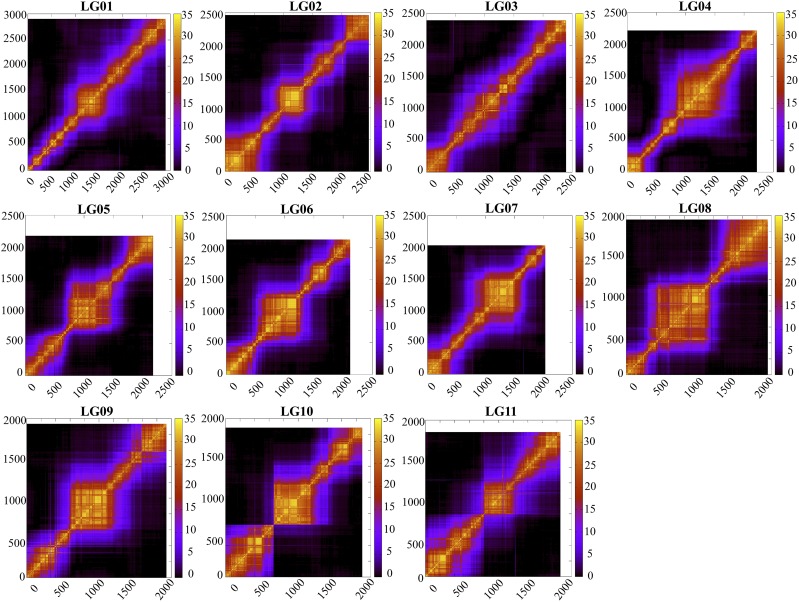
Heat map of the marker linkage relationships in each LG. The plots show the LOD relationship among loci. X- and Y-axes represent the polymorphic ddRAD loci ordered by the linkage map.